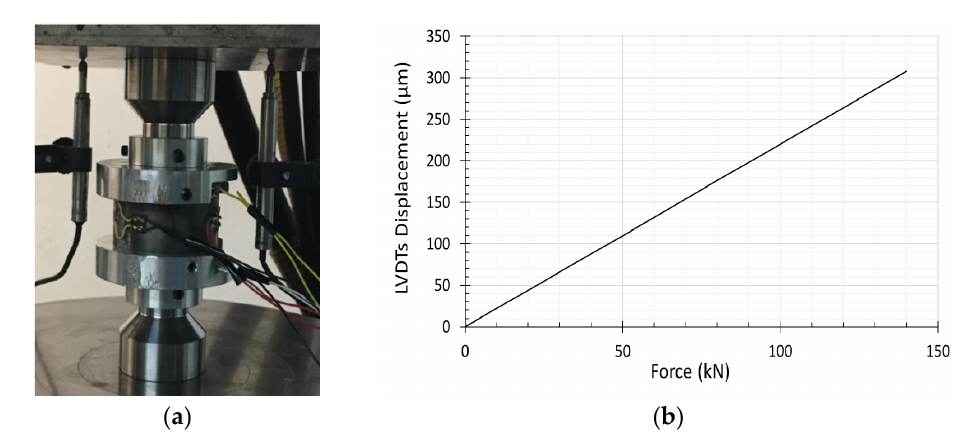
Figure 6. LVDT calibration test: ( a ) Test set up: the confining ring is empty; the two plugs are set at mid distance from the cell; ( b ) Test result: LVDT’s axial displacement versus the applied axial force.